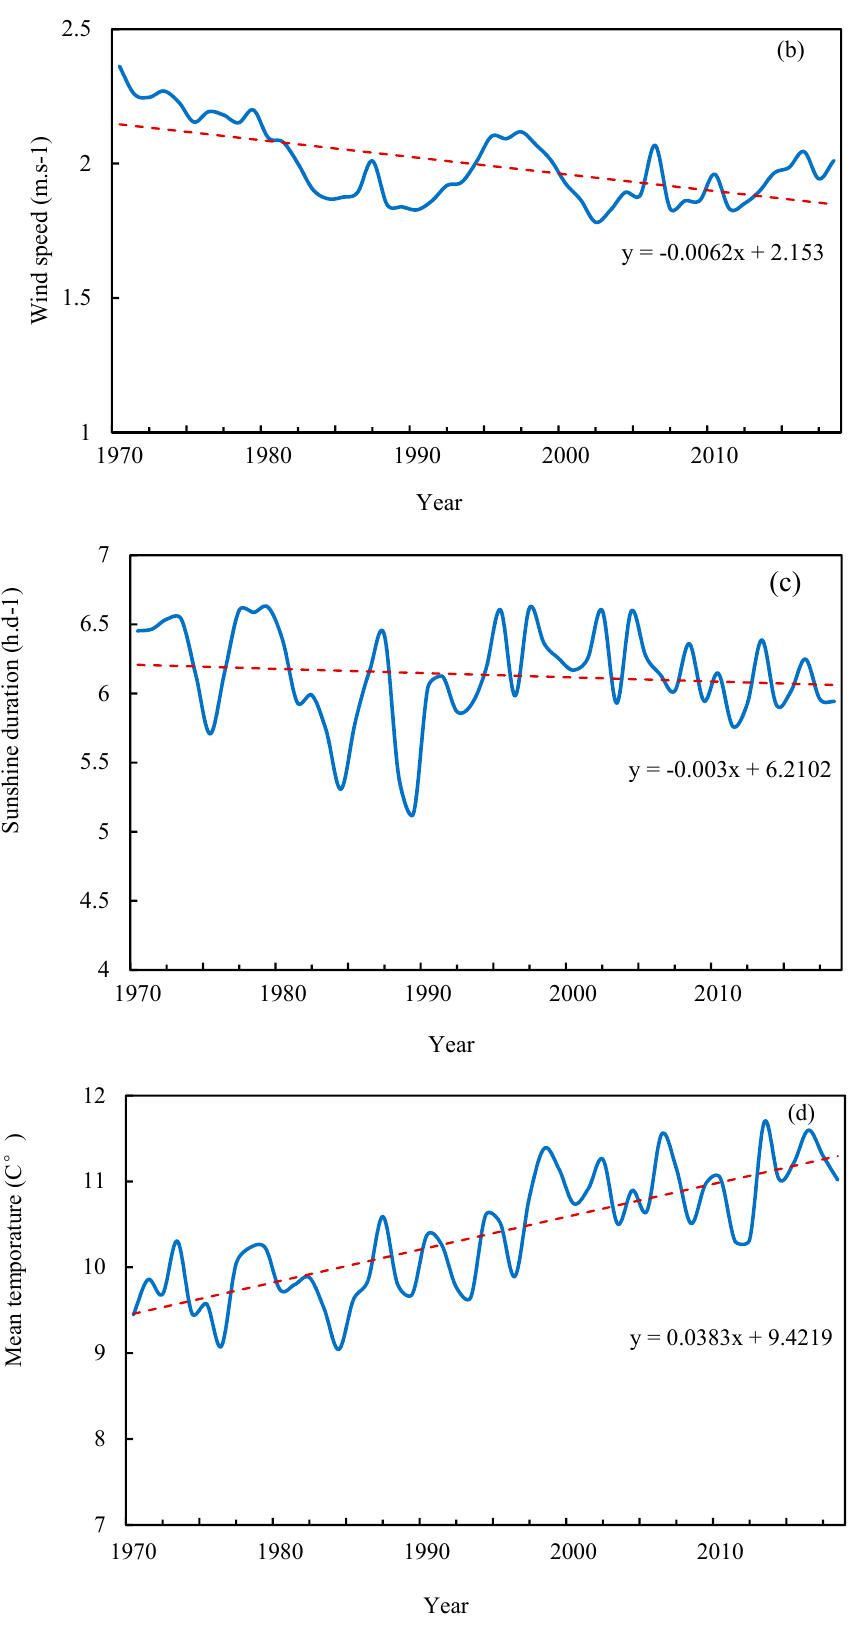
Figure 7. Annual trends of (( a ): Relative humidity, ( b ): Wind speed, ( c ): Sunshine duration, ( d ): Mean temperature) in Weihe River Basin.